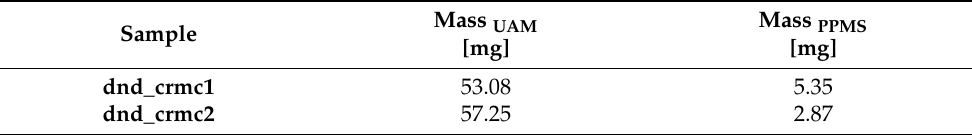
Figure 2. Detonated nanodiamond ceramic samples in different experimental setups for heat capacity measurements. ( Left ): dedicated calorimetric cell of the cryostat at UAM; ( Right ): sample puck of commercial PPMS at ILT&SR PAS. Table 1. Sample masses of particular detonated nanodiamond samples used in different experimental setups.